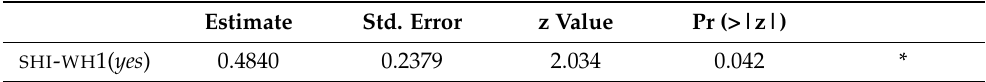
Table 9. Cumulative link mixed model fitted with the Laplace approximation. (Sub-experiment 3’ | | Bare-Adjunct.)